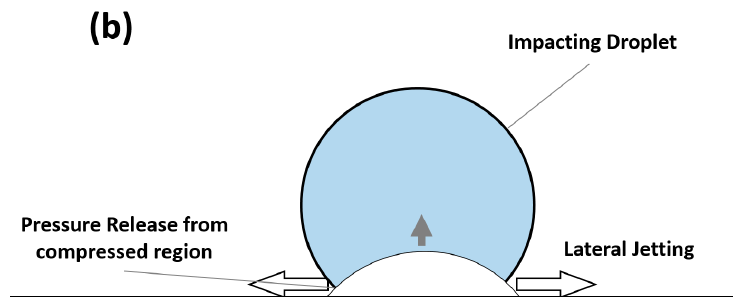
Figure 8. Schematic of the beginning of the lateral jetting formation.